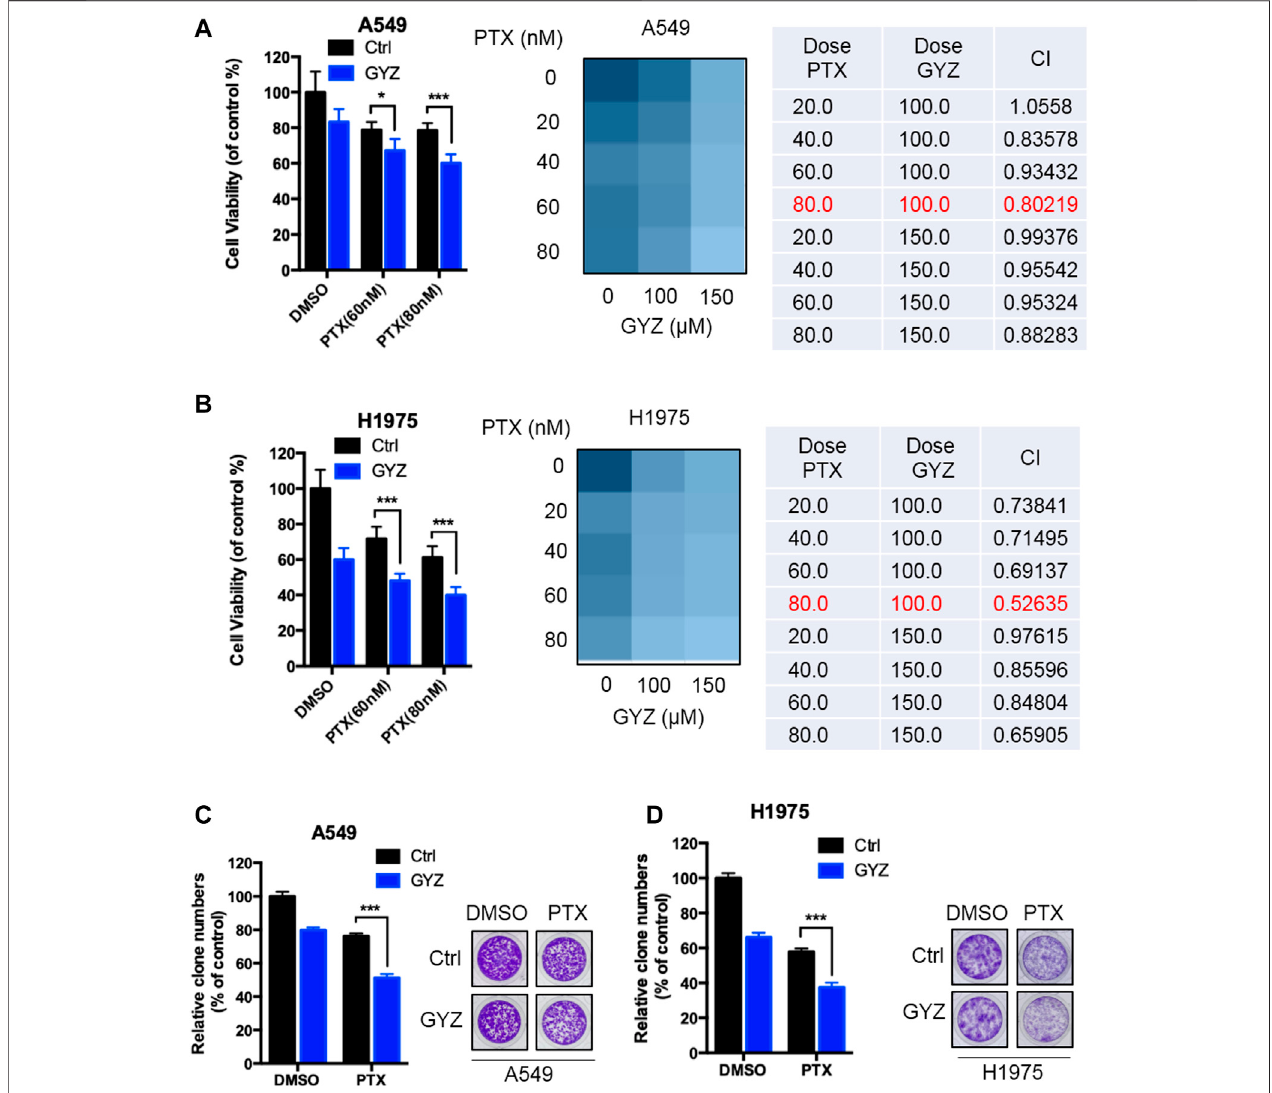
FIGURE 8 | GYZ synergizes with PTX to suppress the growth of NSCLC cells. (A,B) A549 cells (A) and H1975 cells (B) were treated with paclitaxel (PTX) as the indicated doses in the absence or presence of GYZ (100 μ M) for 48 h. Cell growth was evaluated by MTT assay. The combination index (CI) of two drugs was listed. (C,D) A549 cells (C) and H1975 cells (D) were treated with PTX as the indicated doses in the absence or presence of GYZ (100 μ M) for 2 weeks. Cell proliferation was performed by colony-formation assay. All data are means ± SD. * p < 0.05, *** p < 0.001.